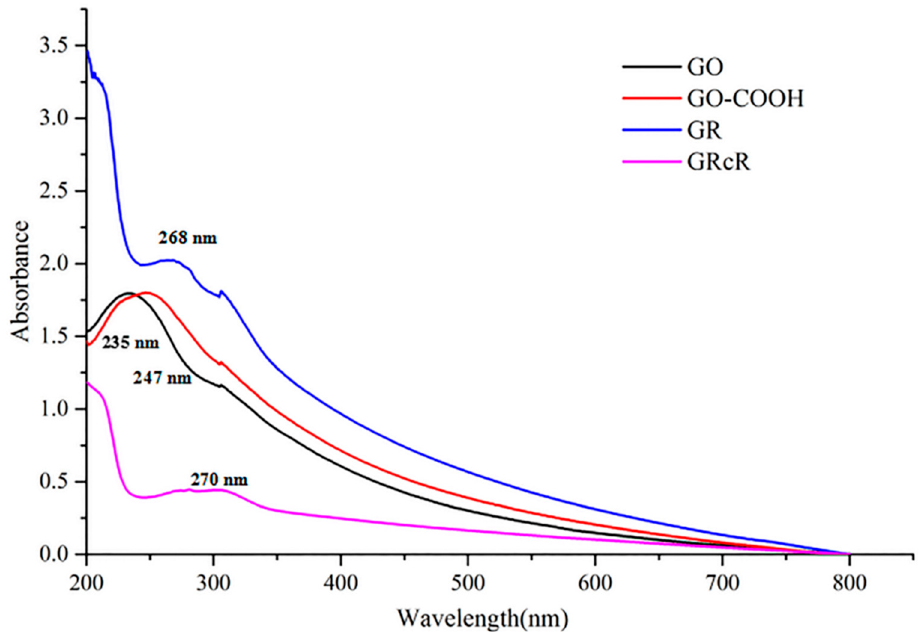
Figure 2. The UV–Vis spectra of GO (black), GO-COOH (red), GR (blue), and GRcR (purple). Morphology studies of GRcR were carried out using transmission electron microscopy (TEM).